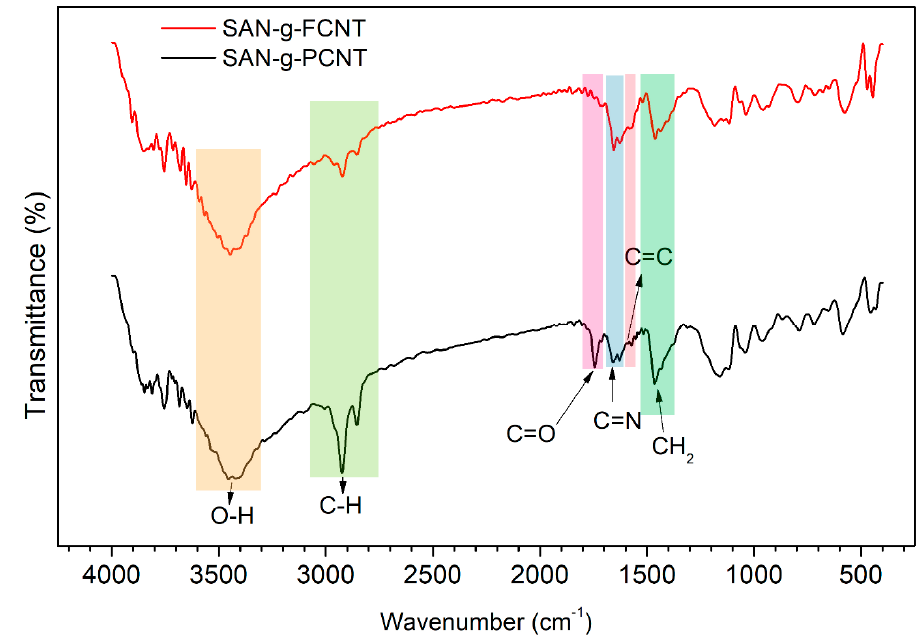
Figure 6. FTIR spectra for the SAN-grafted CNTs: SAN-g-PCNT and SAN-g-FCNT. The covalent bonding of SAN onto MWCNTs both in the pristine and acid-functionalized state is further supported by 1 H-NMR. Figure 7 displays the 1 H-NMR spectroscopy results of the SAN-g-PCNT and SAN-g-FCNTs copolymer in deuterated chloroform after purification. The 1 H-NMR spectra of each material showed all the expected chemical bands, and the SAN grafting polymerization was also confirmed from the broad peaks at 1.3–1.8 ppm (f), at 2.1–2.6 ppm (e), and at 6.8–8.5 ppm (a, b), which correspond to the methylene protons of the styrene and acrylonitrile units, methine protons from styrene and acrylonitrile units, and the aromatic protons of styrene, respectively [39,40].